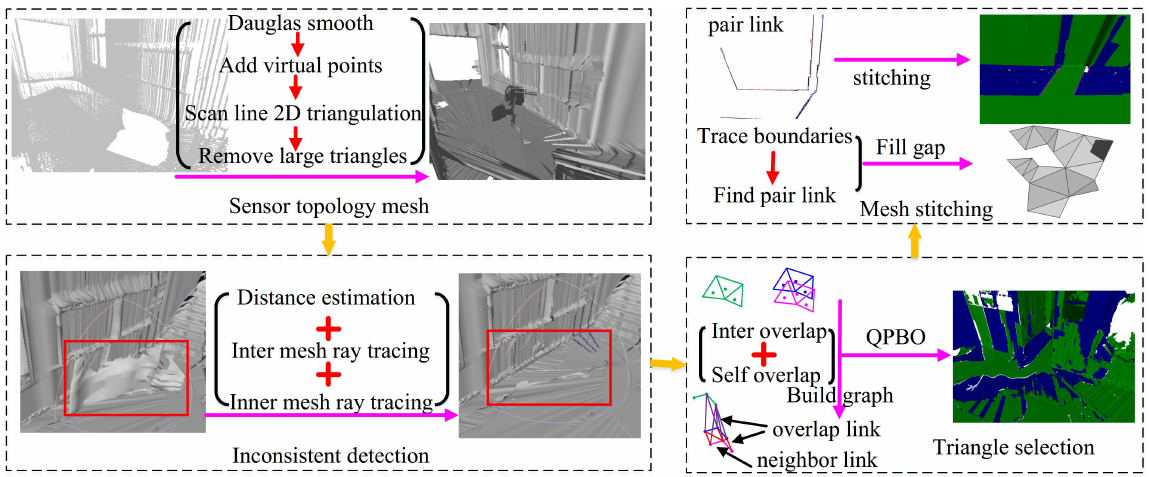
Figure 1. There are 4 steps in our reconstruction pipeline. Step 1 (top left): generate a sensor mesh from each sensor, introducing in Section 3.1 and Section 3.2 ; Step 2 (bottom left): detect and remove the inconsistent objects based on a combination of distance and visibility, the detail is in Section 3.3 ; Step 3 (bottom right): select triangles based on a boolean optimization framework, refer to Section 3.4.1 ; Step 4 (top right): stitch the selected mesh pieces(cf Section 3.4.2 ). values are positive outside and negative inside the solid scene.